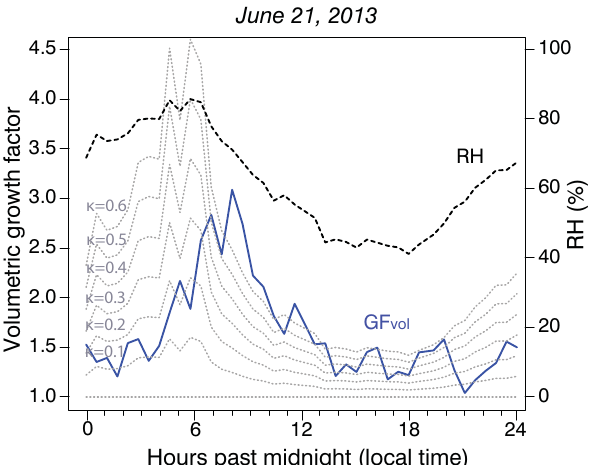
Figure A1. Same as Fig. 7 but for 21 June 2013, a day with no rain- fall. Grey dotted lines indicating median growth factors that were calculated using the same RH and dry volume, and assumed κ val- ues ranging from 0 to 0.6. The black dotted line indicates the RH.